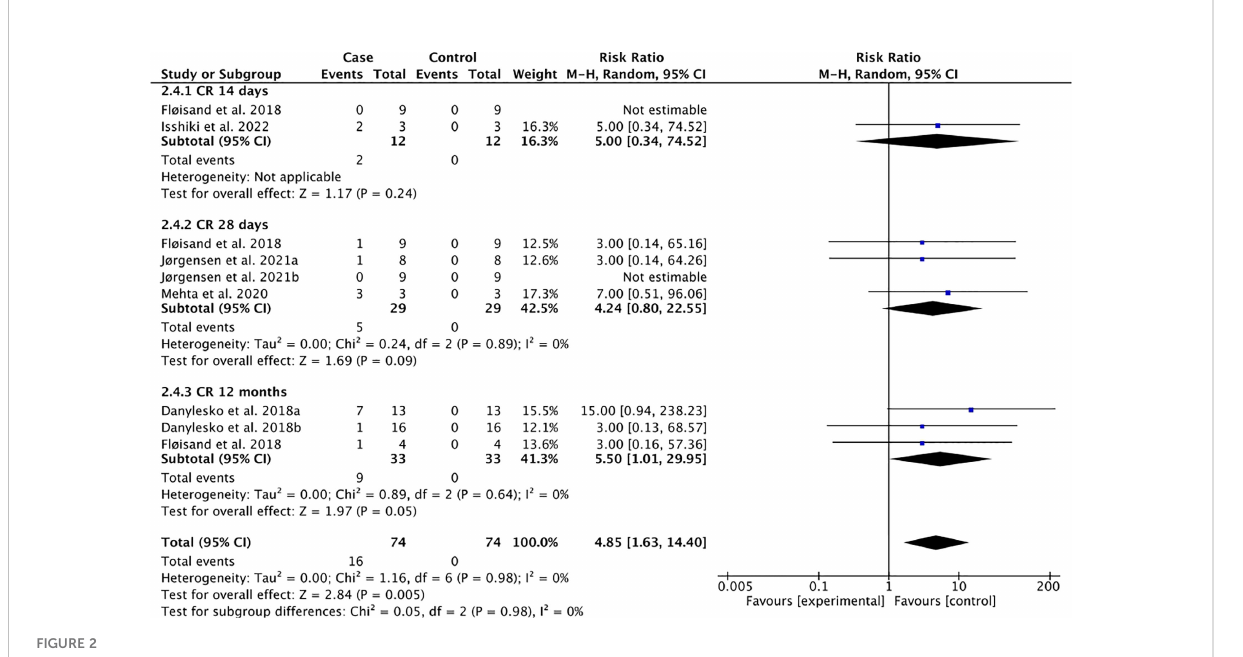
patients across studies, respectively. The risk of adverse events following prophylactic use of vedolizumab did not reach statistical signi fi cance (Figure 4), suggesting the safety of vedolizumab for the prevention of GI-aGVHD in patients undergoing HSCT. Despite the non-signi fi cant risk of most adverse events, the pooled risks for infections (pooled rate = 22.22% of 81 included